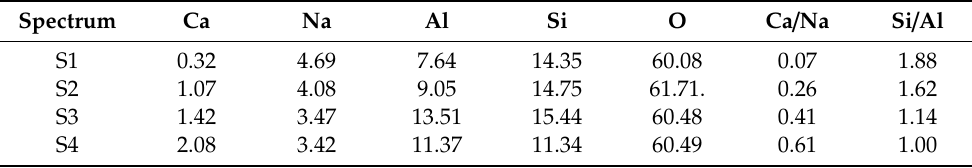
Table 4. Results of EDS of FAGC (atom percent